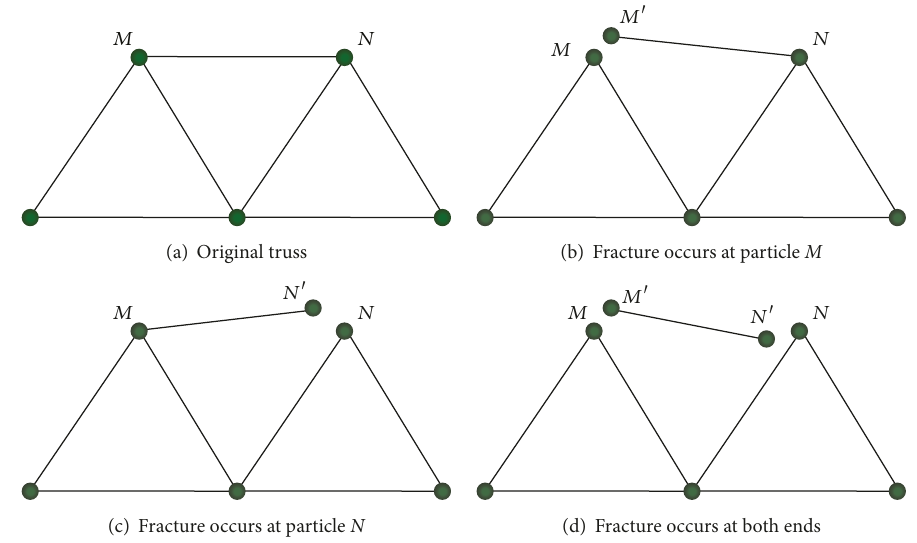
Figure 20: Failure modes of steel members.